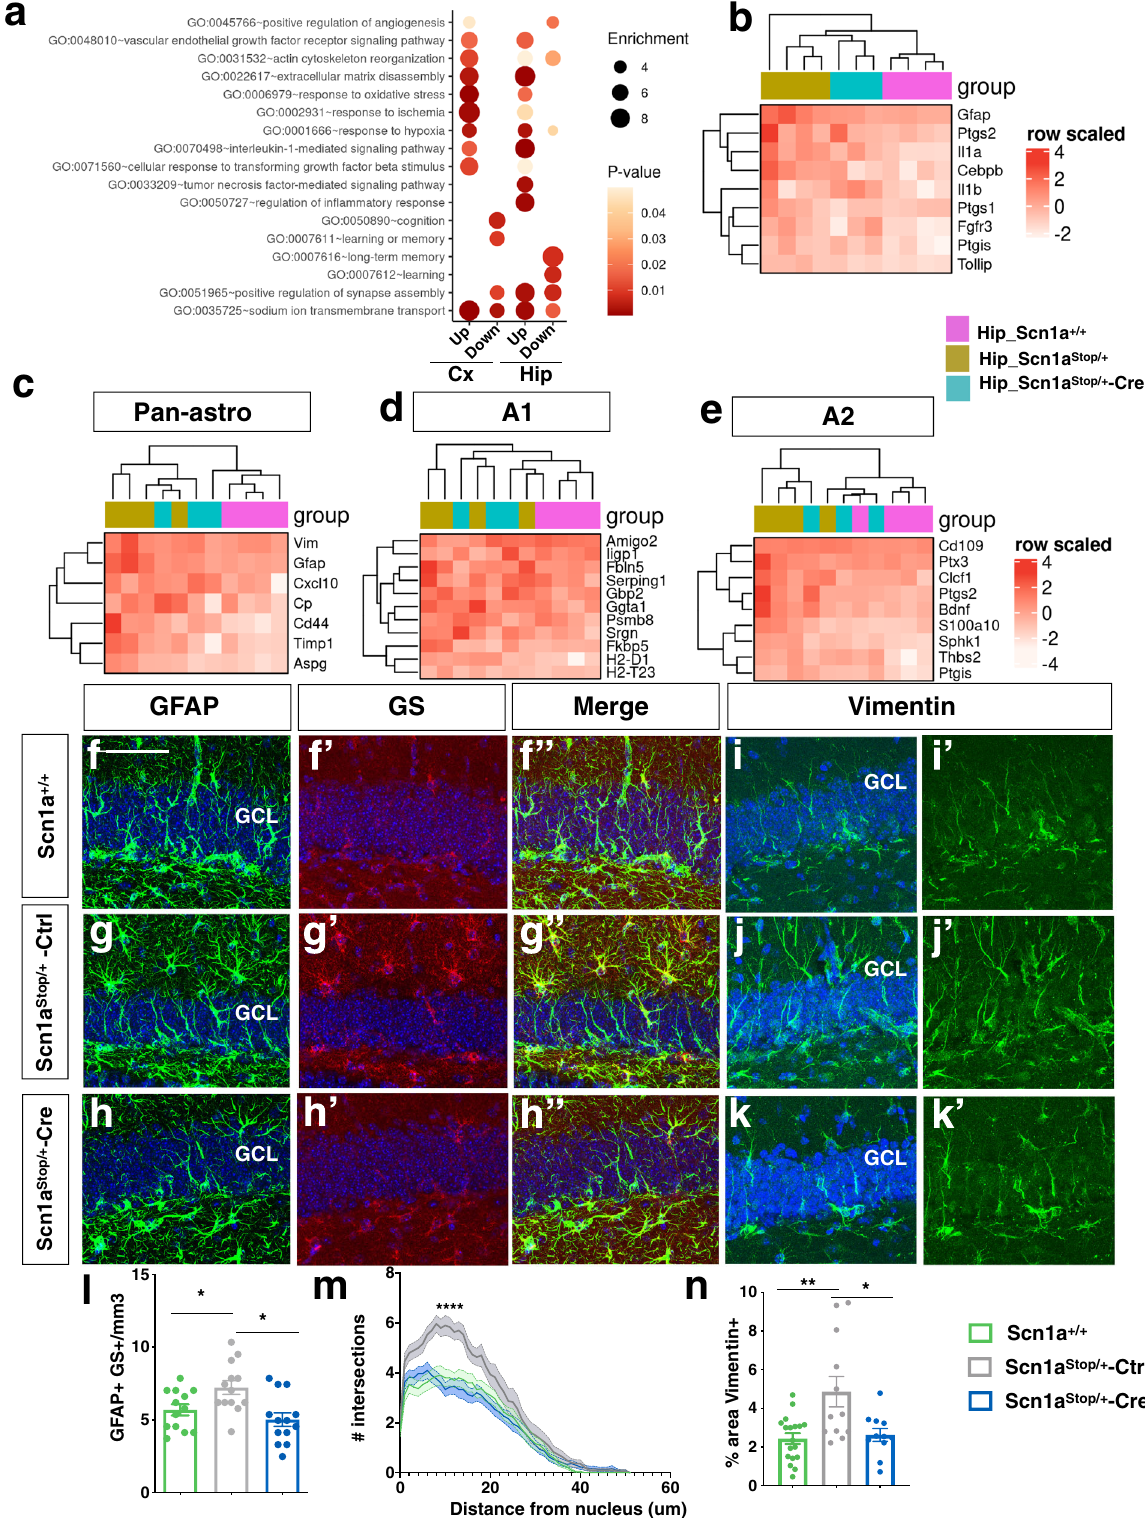
brain by peripheral intra-vascular administration 15,39 , an ideal route also for treating DS patients. This approach, although not based on the delivery of a proper gene therapy, offered the pos- sibility to mimic that treatment and its related challenges such as virus titration, time required for viral gene expression, and bio- distribution in different brain